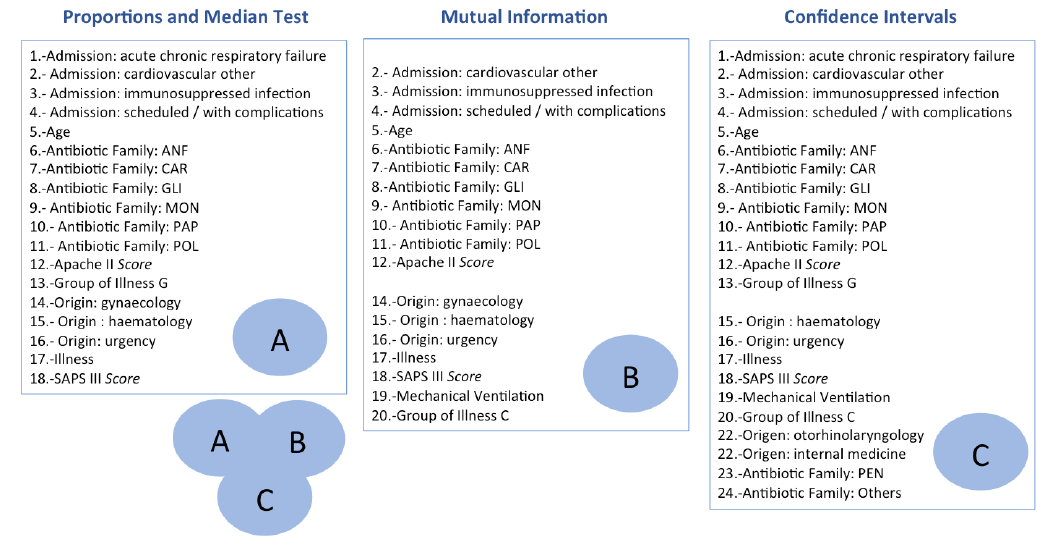
Figure 12. Description of the selected features with the three Feature Selection (FS) methods: Proportions and Median Test, MI and CI. The final set of selected features is the union of the features identified with each FS